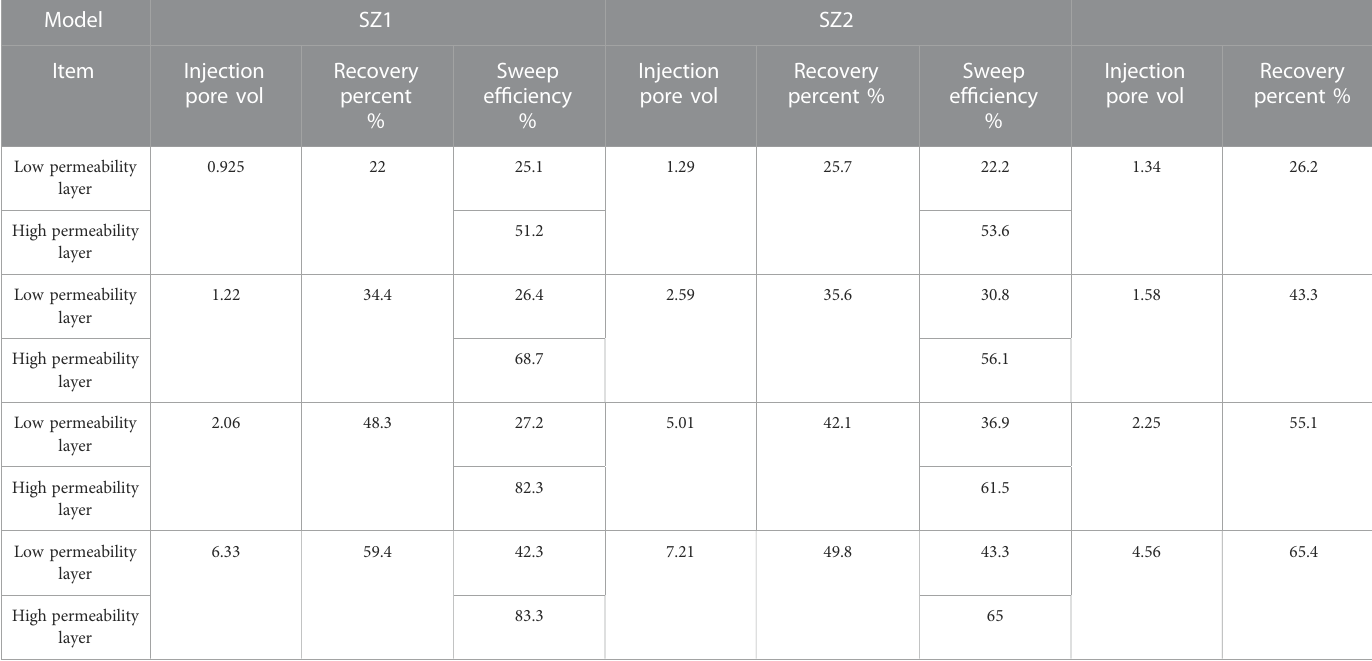
TABLE 2 Data of recovery percent and sweep ef fi ciency of three models during test